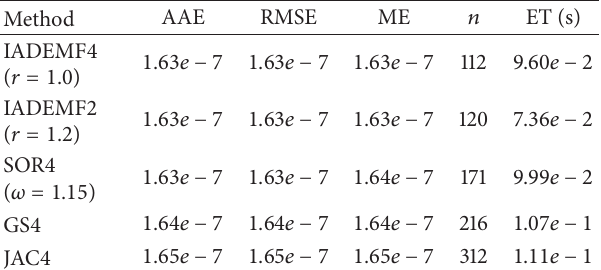
Table 7: Experiment 1. 𝑚 = 7000 , 𝜆 = 1.0 , Δ𝑥 = 1.43 × 10 −4 , Δ𝑡 = 2.04 × 10 −8 , 𝑡 = 5.1 × 10 −7 , and 𝜀 = 10 −10 .